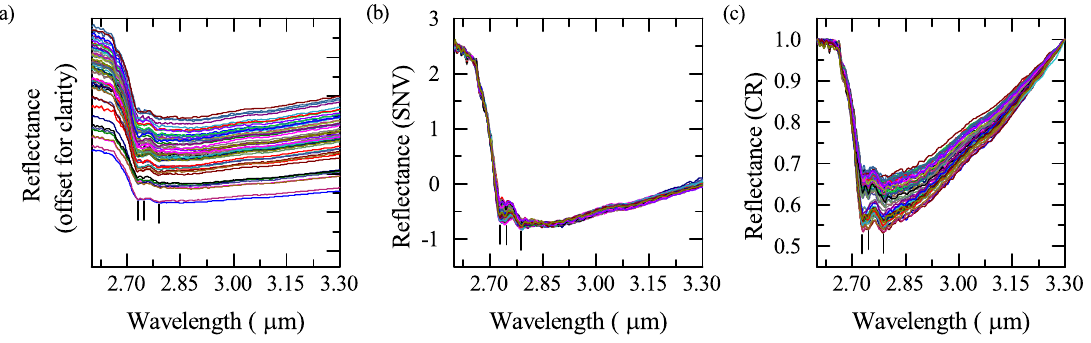
Figure 4. ( a ) Raw; ( b ) standard normal variate (SNV); and ( c ) continuum removal (CR) processed infrared spectra of calcined kaolin in the 2.6 to 3.3µm region. The markers indicate wavelength positions at 2.73, 2.75 and 2.78µm.